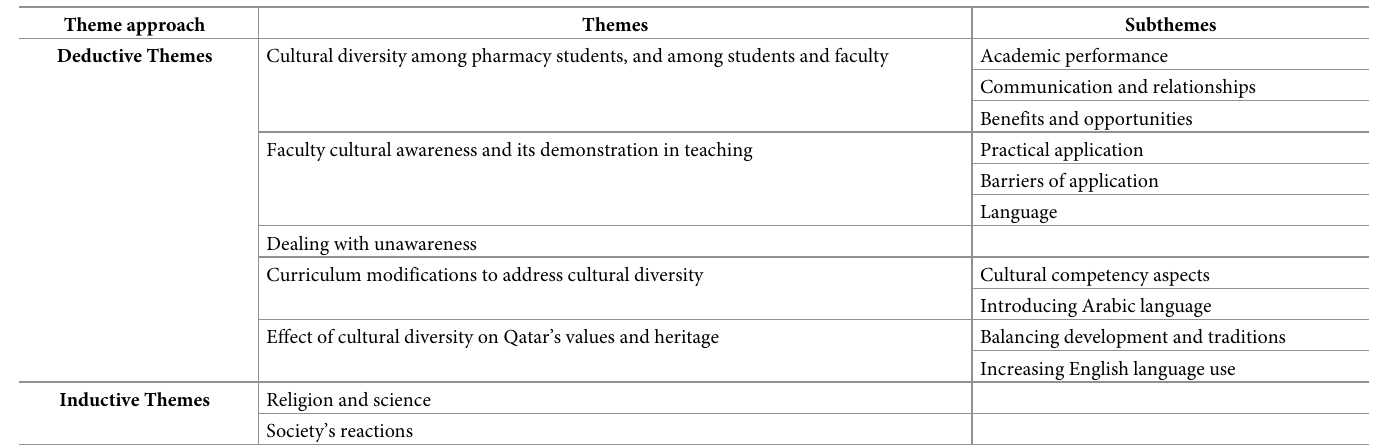
Table 7. Themes and subthemes generated from the